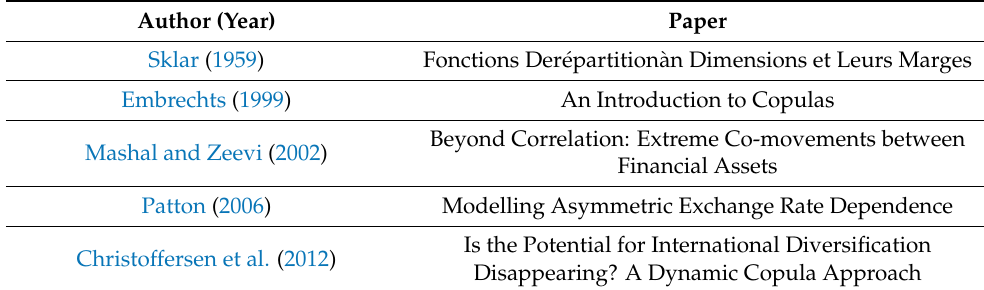
Table 3. Selected works on